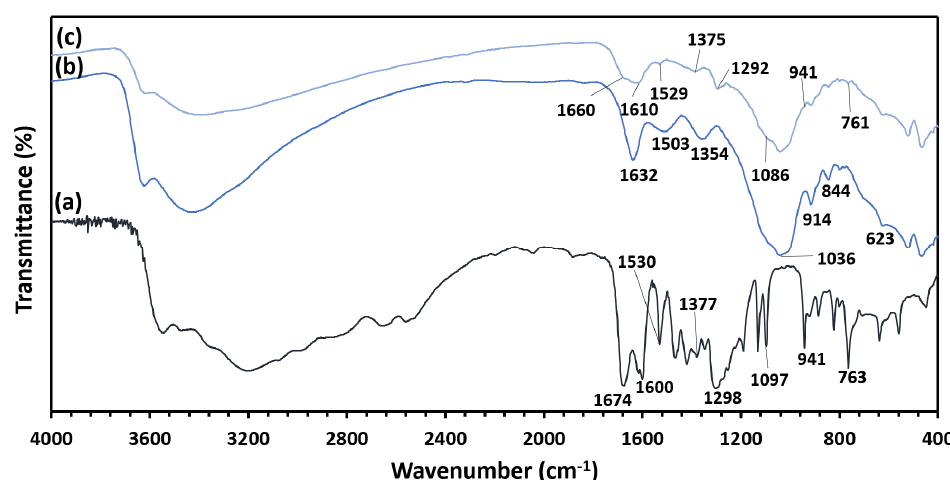
Figure 6. FTIR spectra of ( a ) PCA, ( b ) MMT / CR / Fe 3 O 4 -NCs and ( c ) MMT / CR / Fe 3 O 4 -PCA.